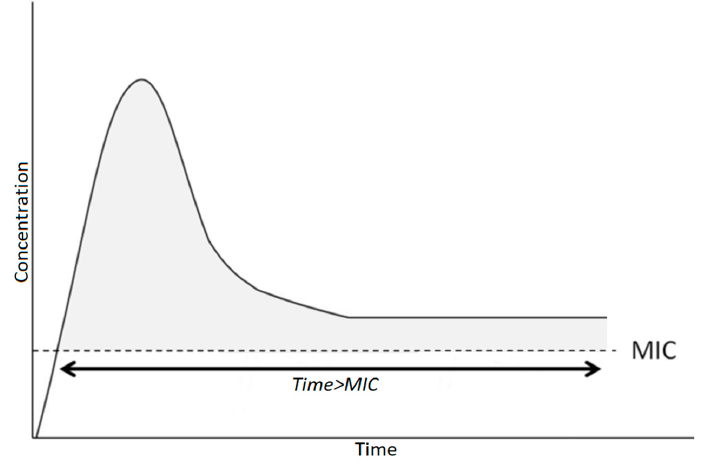
Figure 2. Pharmacokinetics of time-dependent drugs administered in continuous infusion.